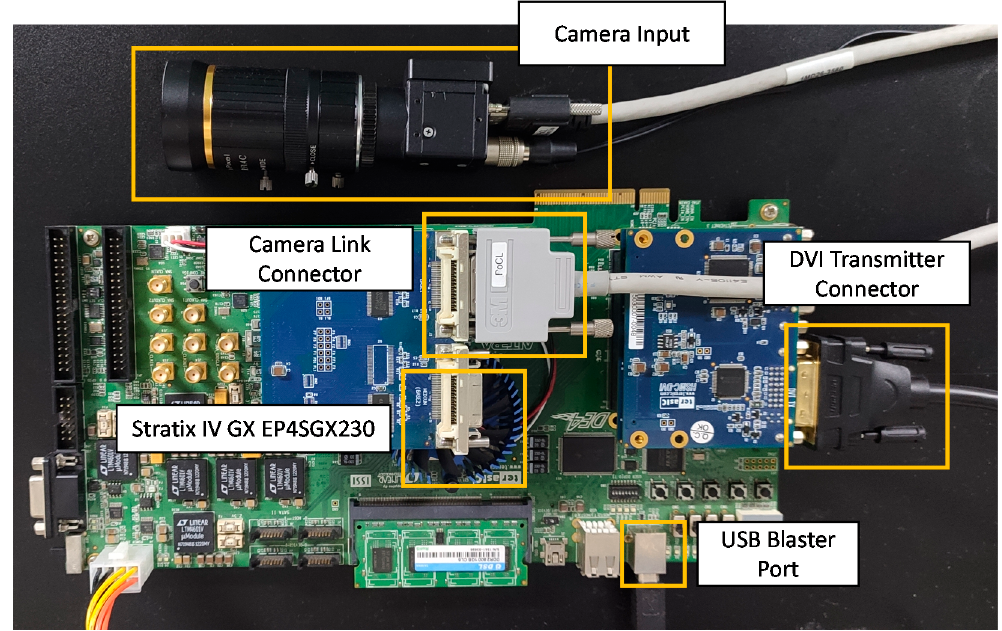
Figure 6. FPGA-based prototype system deployed on the Intel DE4 development board (Stratix IV GX EP4SGX230).